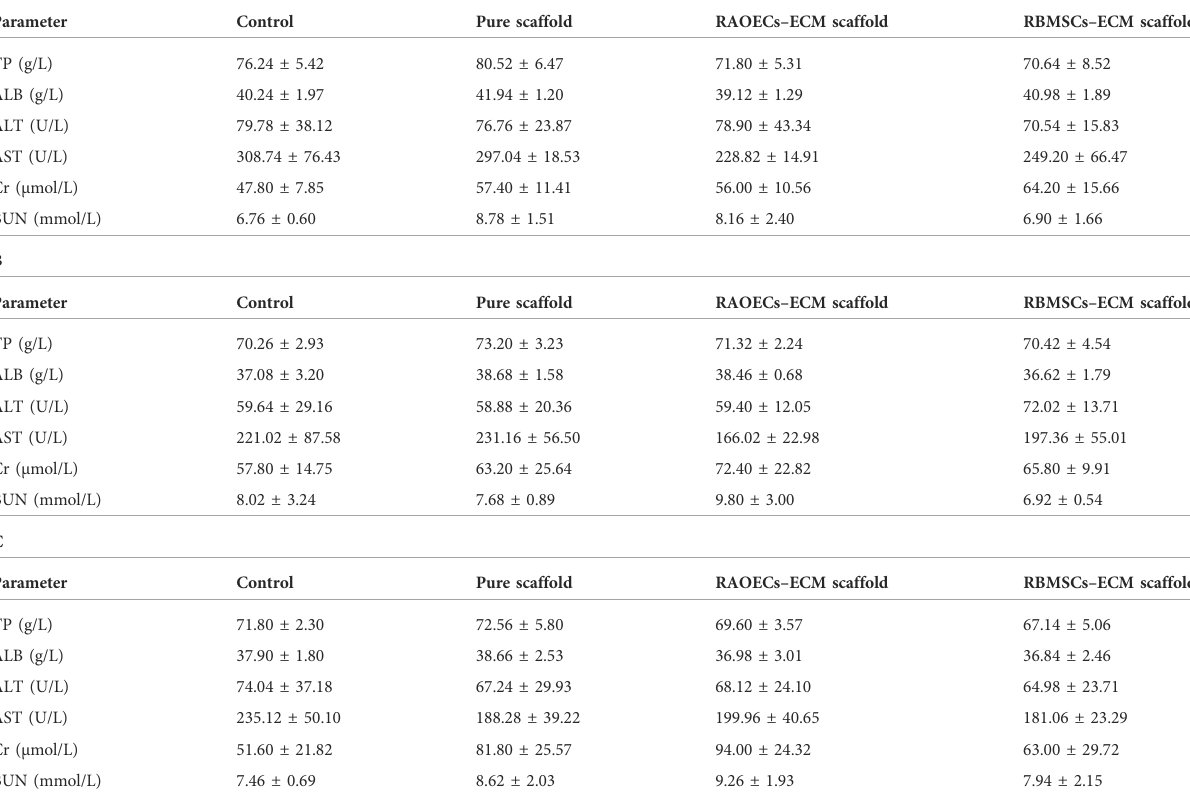
TABLE 2 Differences in some biochemical indices among groups of rats implanted with ECM – loaded scaffolds, pure scaffold and control at different times after